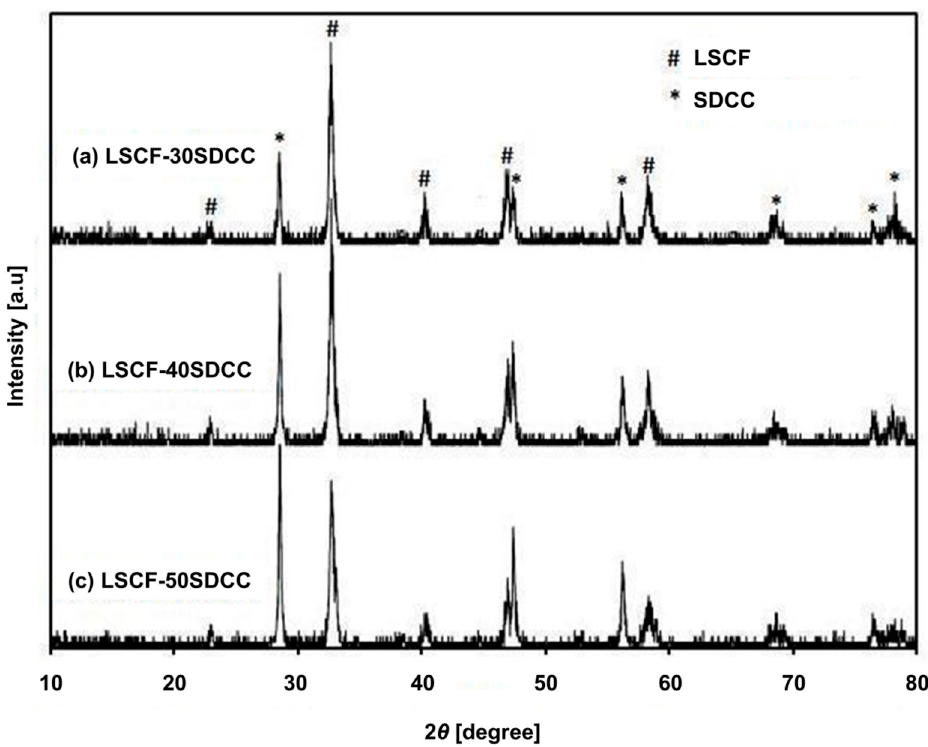
Figure 3. XRD patterns of LSCF–SDCC composite cathodes with different SDCC electrolyte contents: ( a ) LSCF–30SDCC, ( b ) LSCF–40SDCC, and ( c ) LSCF–50SDCC. Table 1. Properties of the composite cathode LSCF–SDCC powders. Surface Area Average Samples